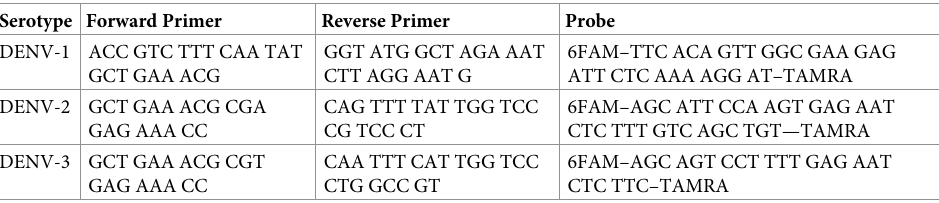
Table 1. Primer and probe sequences used in this